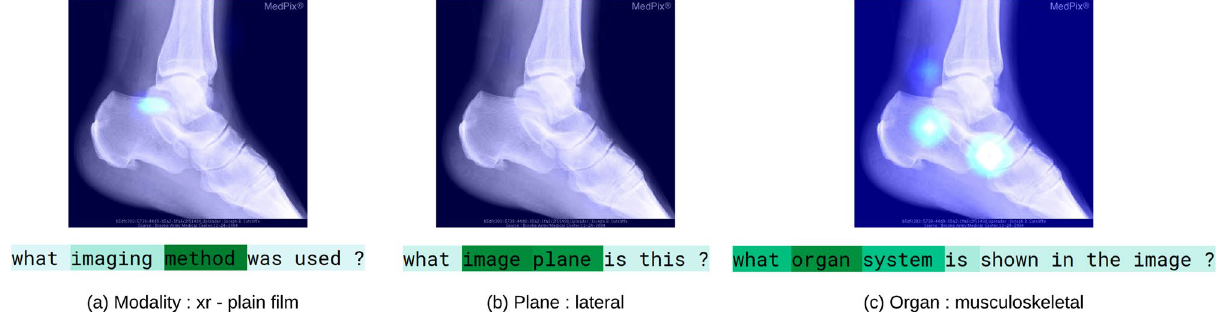
Figure 5. Co-Attention Maps for a sample case to display the attention span of MedFuseNet with the input image and the corresponding question attention. ( a ) Displays the image attention map and the corresponding